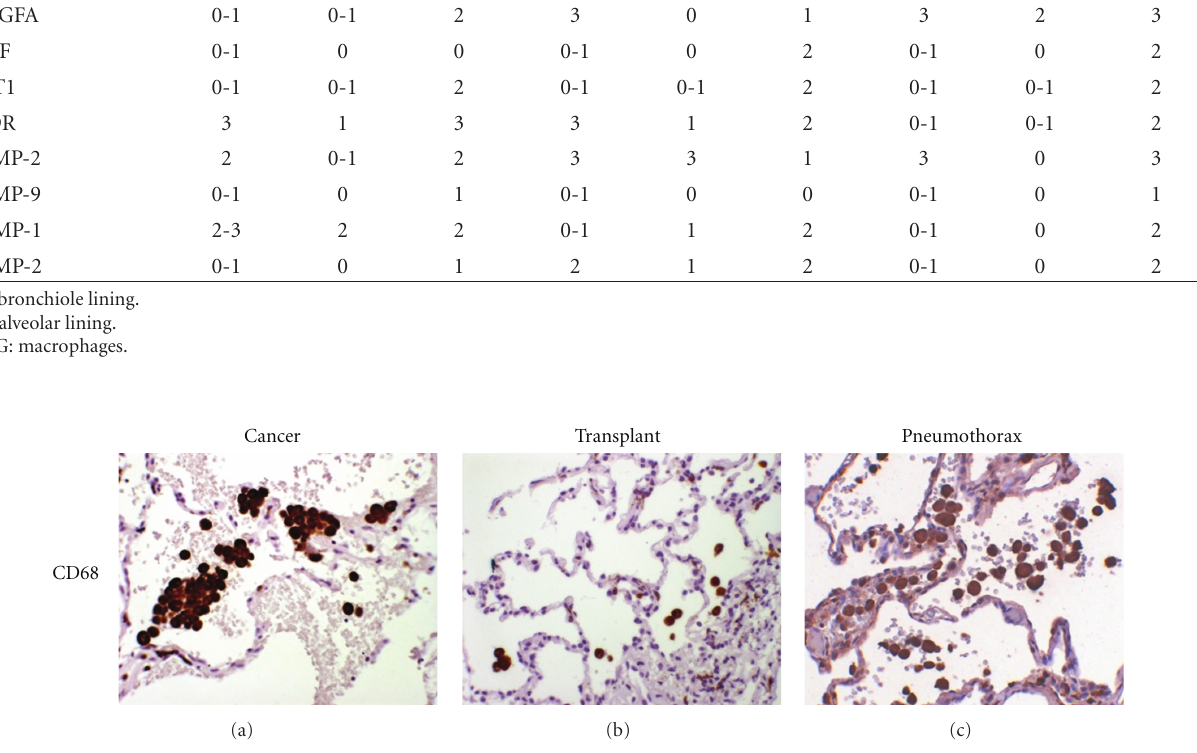
Figure 2: Immunohistochemical staining for CD68. The distribution of CD68+ macrophages in lung cancer resection (a), transplant biopsy (b), and pneumothorax (c). Magnification